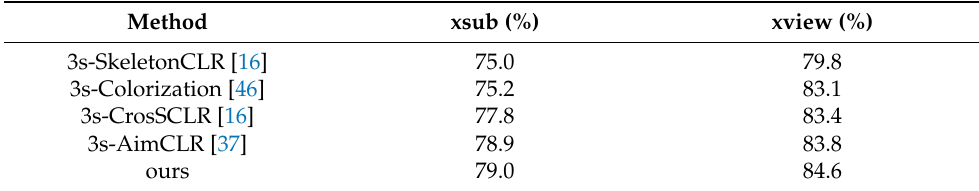
Table 4. Linear evaluation results on NTU-60